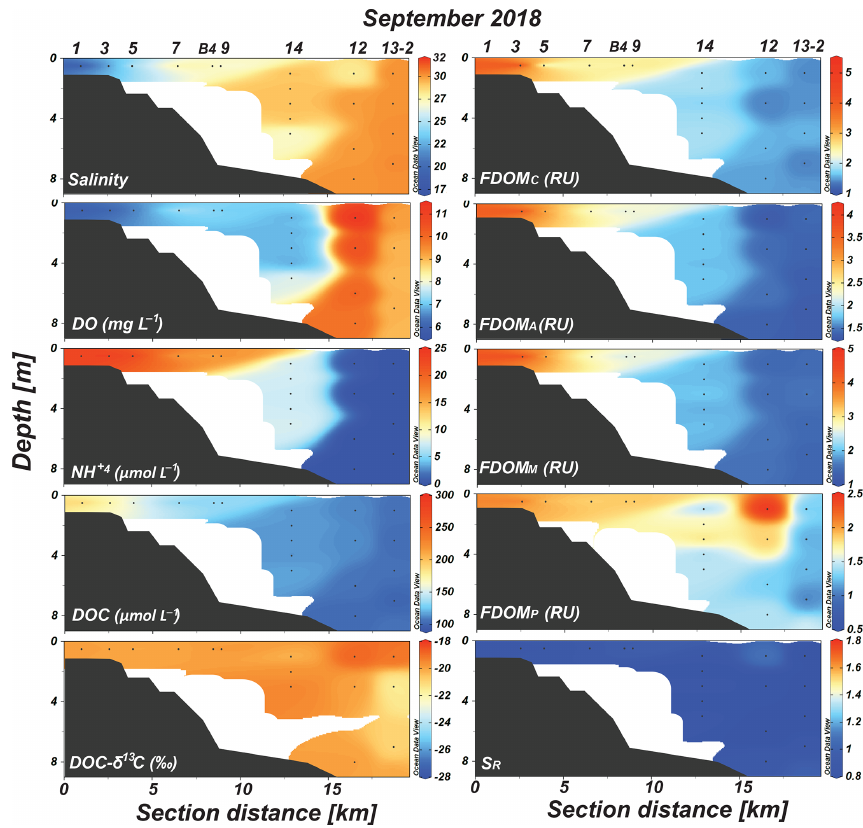
Figure 3. Vertical distributions of salinity, DO, NH + Lake in September